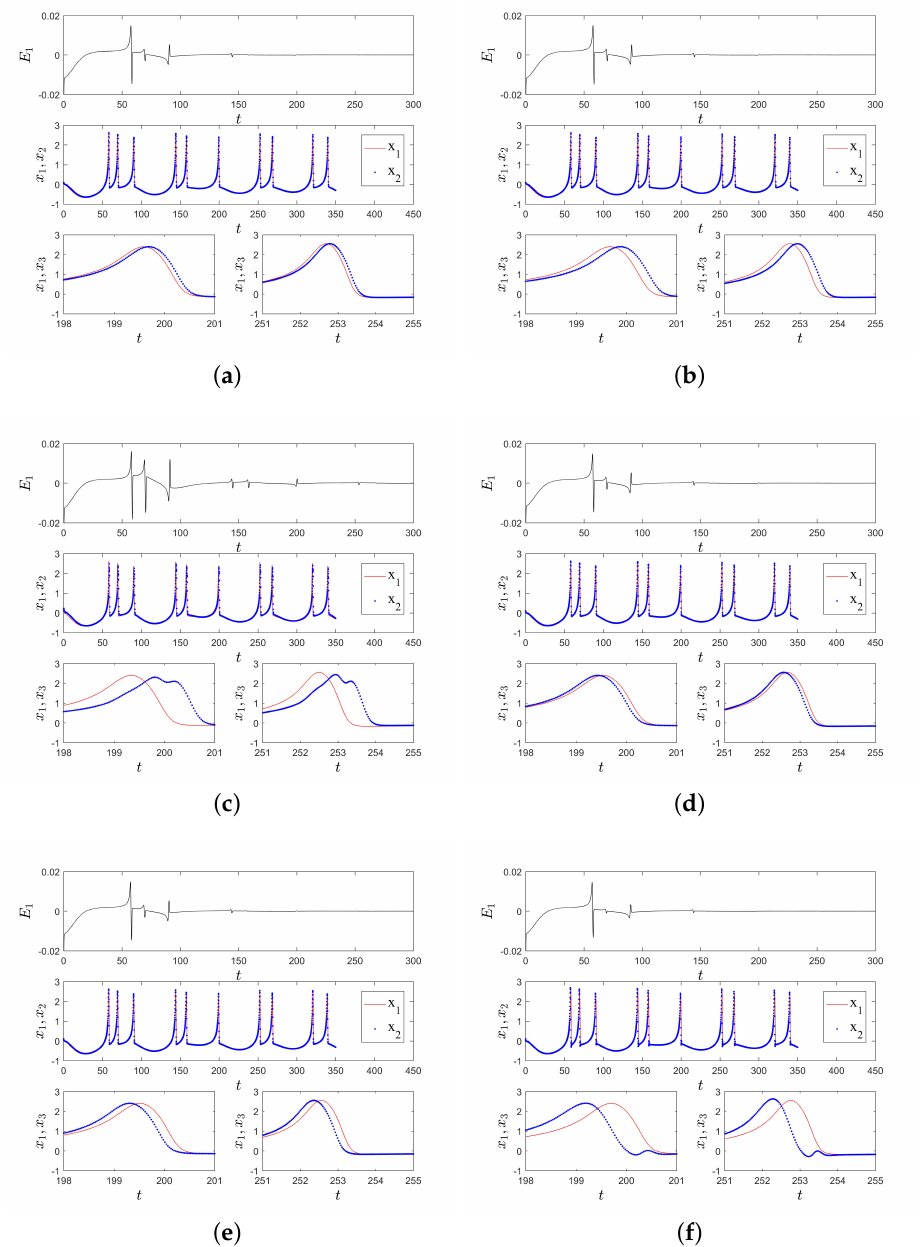
Figure 4. Synchronization errors and functional relation between x 1 and x 2 in System (27) with J ( x 1 ) = Q ( x 1 , y 1 , z 1 , τ ) , α = − 1.3 and ( a ) τ = 0.1, ( b ) τ = 0.2, ( c ) τ = 0.5, ( d ) τ = − 0.1, ( e ) τ = − 0.2, and ( f ) τ = −